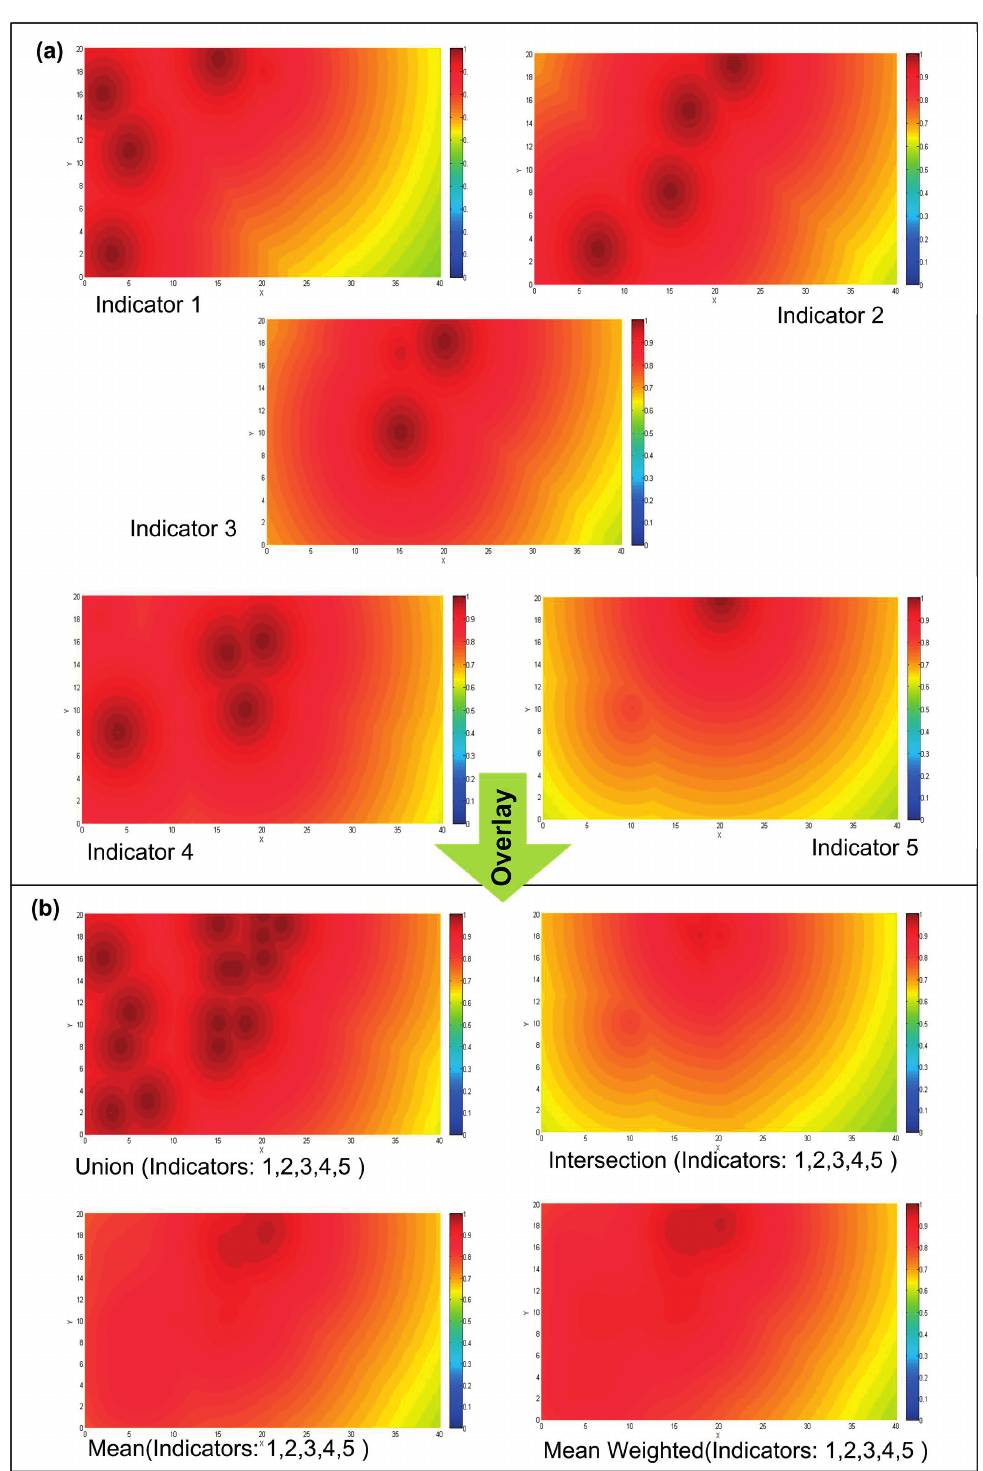
Figure 7. ( a ) Representation of five different indicators. ( b ) Fuzzy aggregation of these indicators: an overlay operation (union, intersection, mean, and weighted